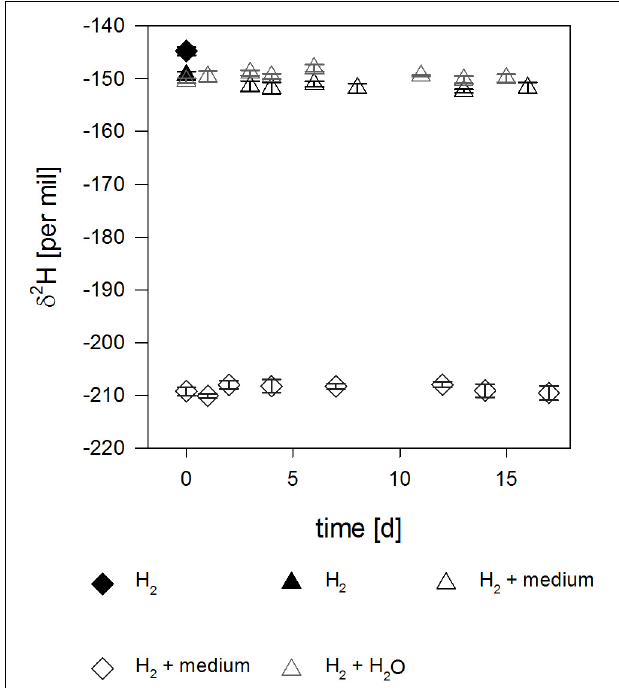
FIGURE 1 | Isotope signal over time in the abiotic controls. Filled symbols correspond to pure H 2 used for the experiment and empty symbols correspond to H 2 in the headspace of serum bottles filled with either water (gray) or medium (black). Please note the depleted δ 2 H-values of H 2 (empty diamonds) for the medium prepared in the anaerobe glovebox due to mixing of two isotopically different H 2 sources (see text).